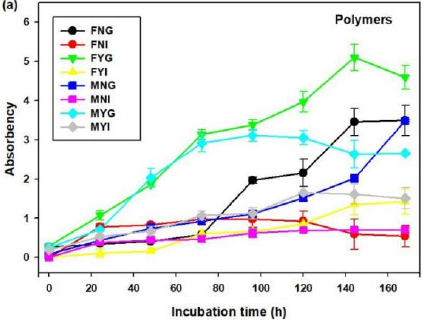
Figure 8. Average well color development (AWCD) variation in EcoPlates.